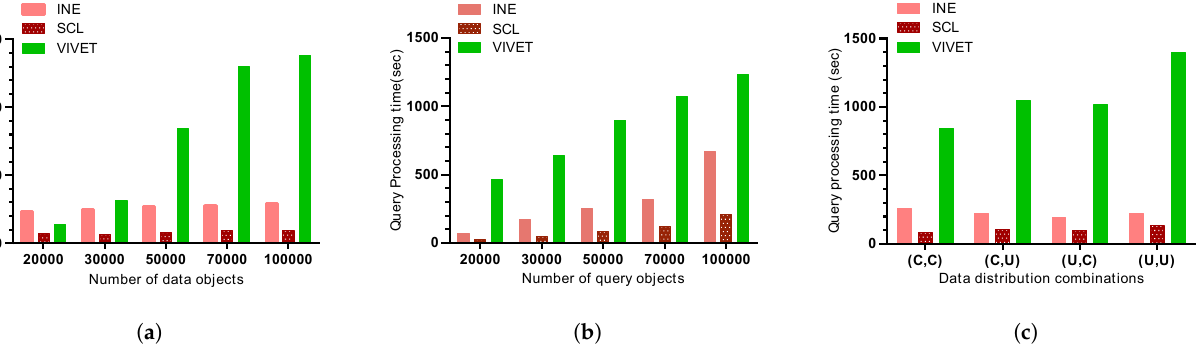
Figure 9. Comparison of INE, SCL, and VIVET for OLDEN: ( a ) varying D; ( b ) varying Q; ( c ) varying the distribution of